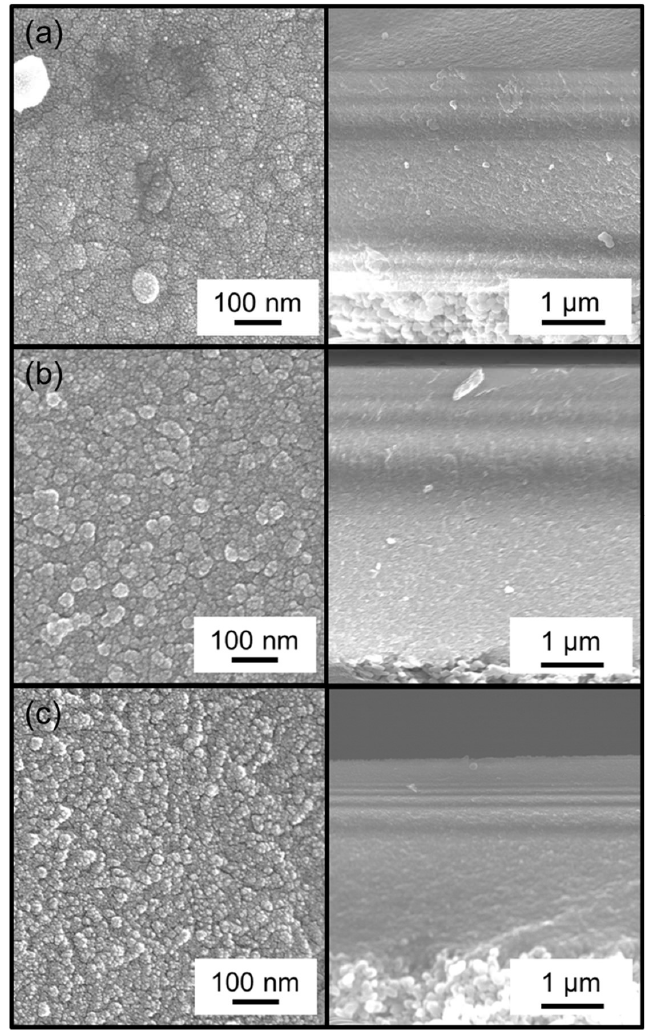
Figure 3. Surface (left) and cross-sectional (right) SEM images of the MTMOS-derived membranes deposited with residence times of ( a ) 0.4 s, ( b ) 0.8 s, and ( c ) 1.3 s.